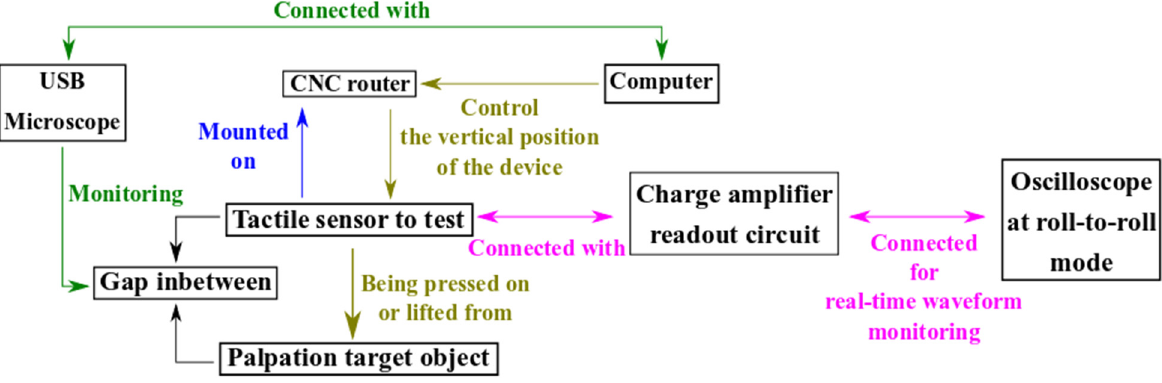
Figure 5. Schematic of the hardware setup to test the fabricated tactile sensor. Table 2. List of hardware equipment used to test the polymeric piezoelectric tactile